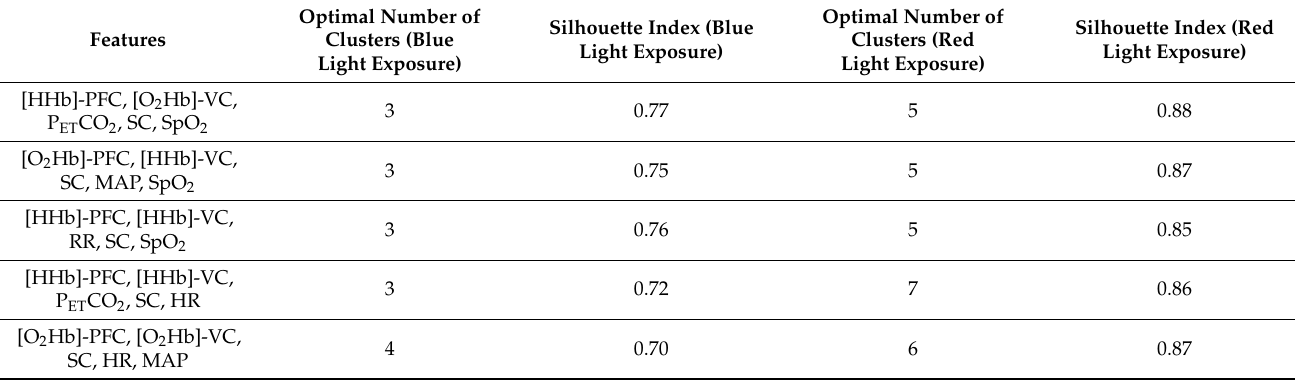
Table 1. Summary of the best five sets of cerebrovascular and systemic physiological parameters for subject classification. The optimal number of clusters with the corresponding silhouette index criterion is shown for both the blue and red light exposure